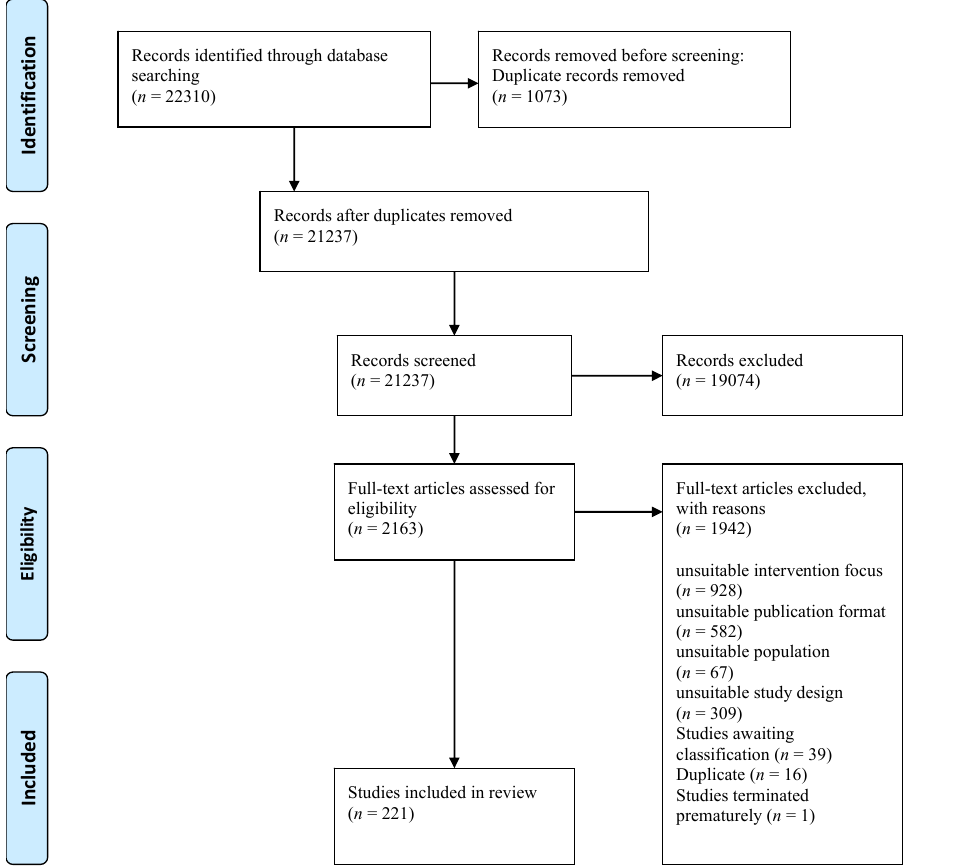
Figure 1. PRISMA flow diagram.